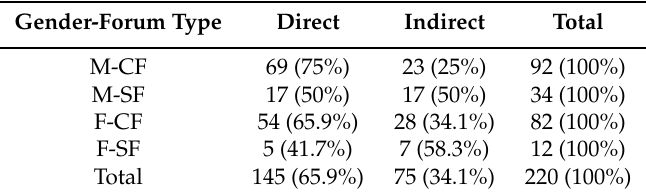
Table 9. Support seeking strategy, gender, and forum type. M = Male; F =